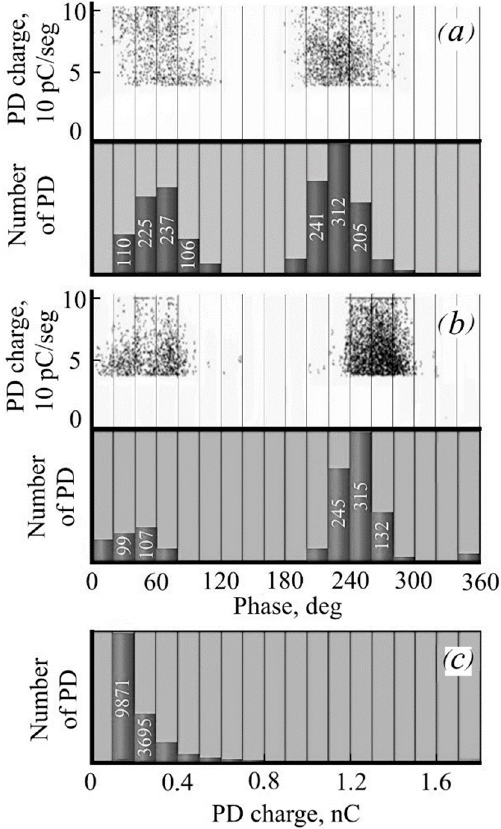
Figure 5. PD characteristics for an operating low-defect insulator No. 2: ( a ) amplitude–phase characteristic and the dependence of the number of PDs on the phase angle, detected by the electromagnetic sensor; ( b ) amplitude–phase characteristic and the dependence of the number of PDs on the phase angle, detected by the acoustic sensor and ( c ) dependence of the amount of PD on the intensity.